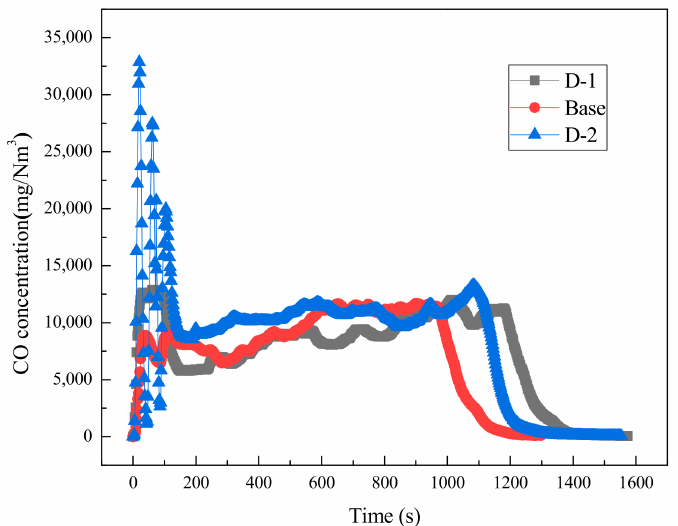
Figure 11. CO emission concentration during sintering at different negative pressure. (The negative pressure: D-1 = − 11 kPa; Base = − 12 kPa; D-2 = − 13